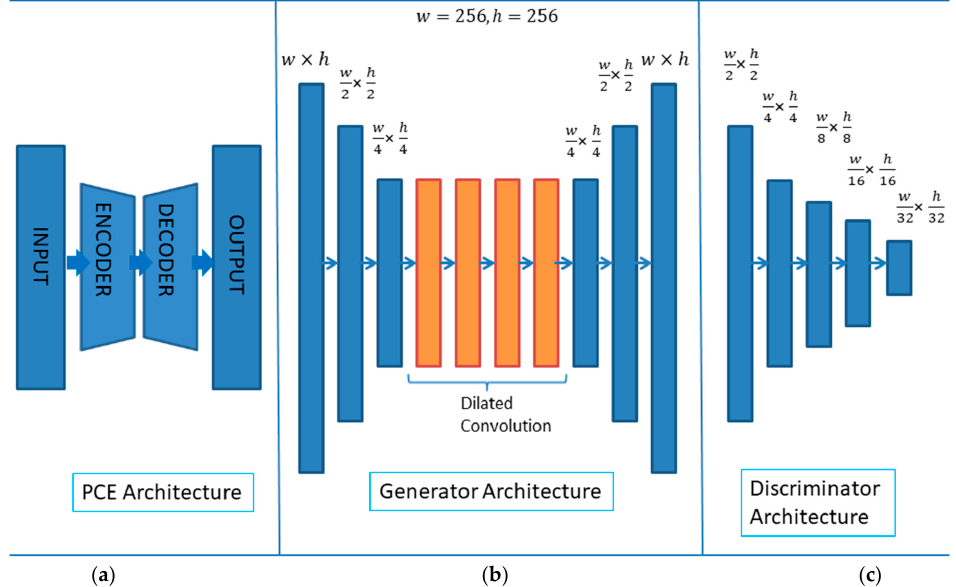
Figure 3. Pixel Context Encoder (PCE) ( a ) General Architecture of PCE ( b ) Encoder decoder-based Generator Architecture and ( c ) Discriminator Architecture .